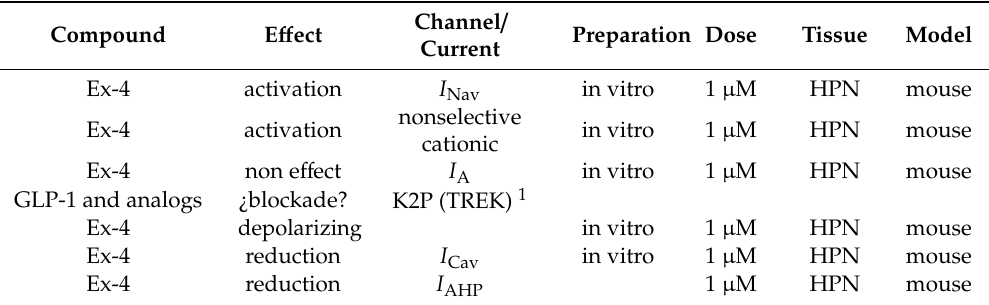
Table 1. Electrophysiological e ff ects of GLP1 in the